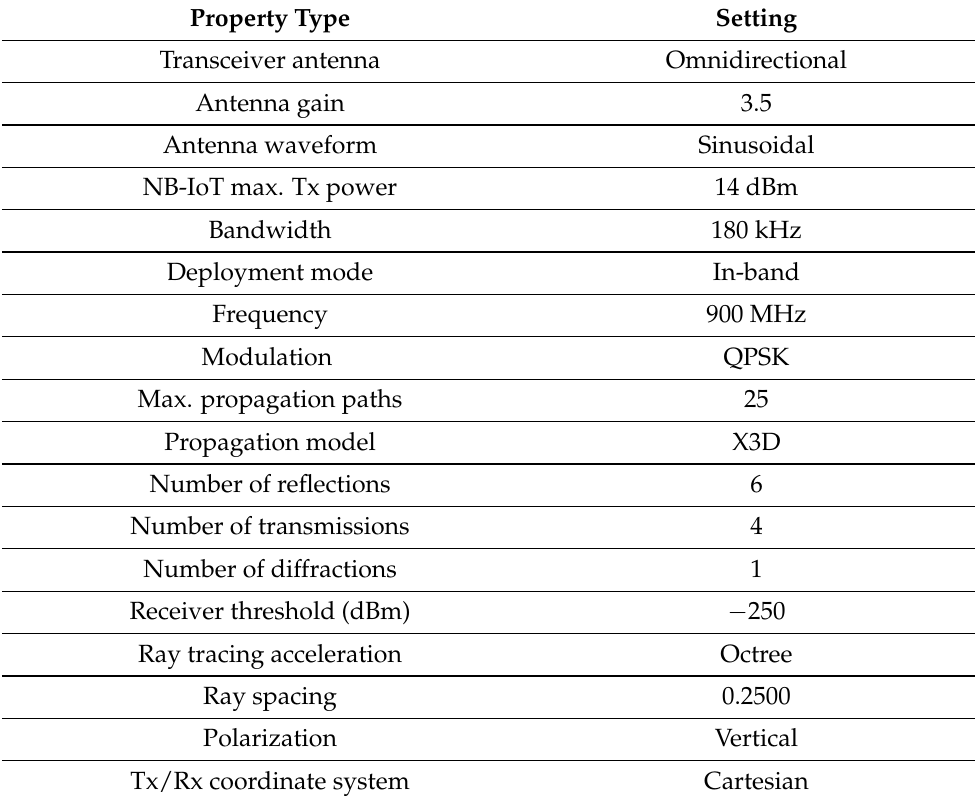
Table 1. WI parameter settings used for simulation of the modeled